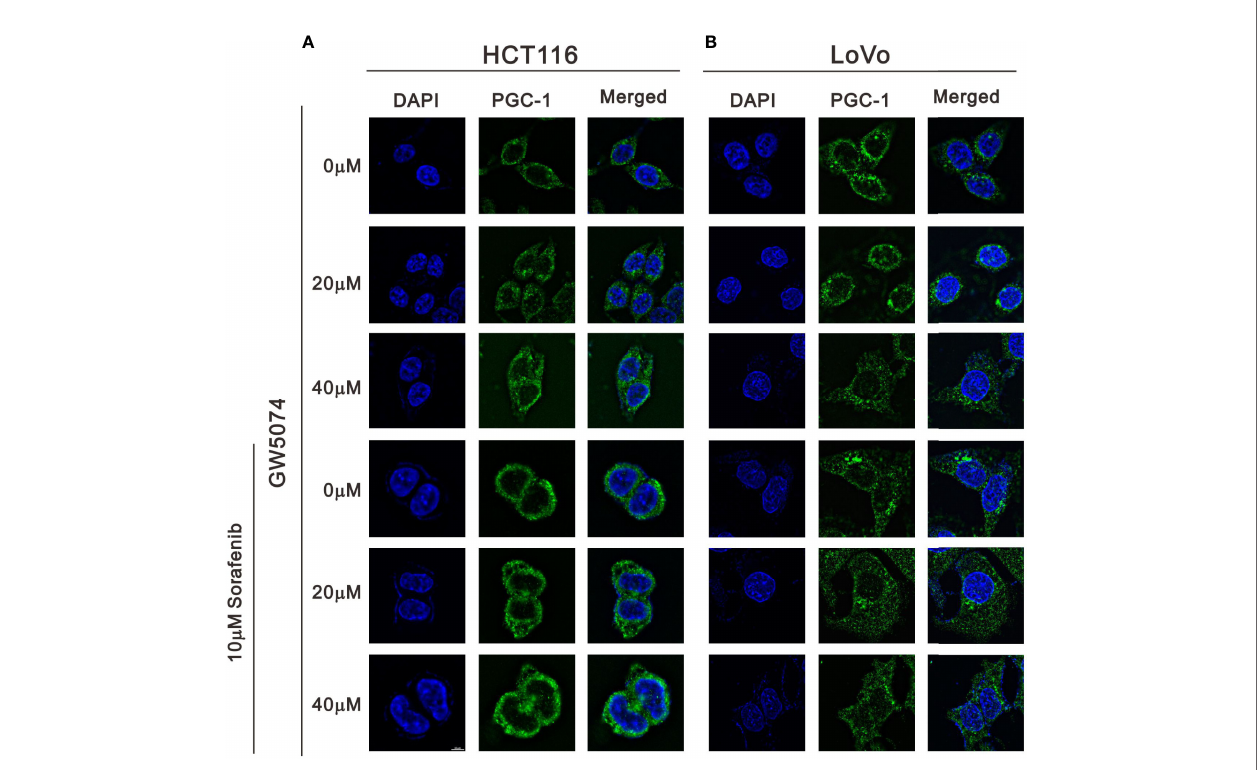
FIGURE 12 | The effects of GW5074 and sorafenib on the expression of PGC-1 a in HCT116 and LoVo cells. HCT116 (A) and LoVo (B) cells were treated with 0, 20, and 40 µM GW5074 in the absence or presence of 10 µM sorafenib for 24 h and were immune-stained with anti-PGC-1 a (green) and DAPI (blue). Images were examined under a Leica Thunder microscope with a 100x objective. Scale Bar=10 m